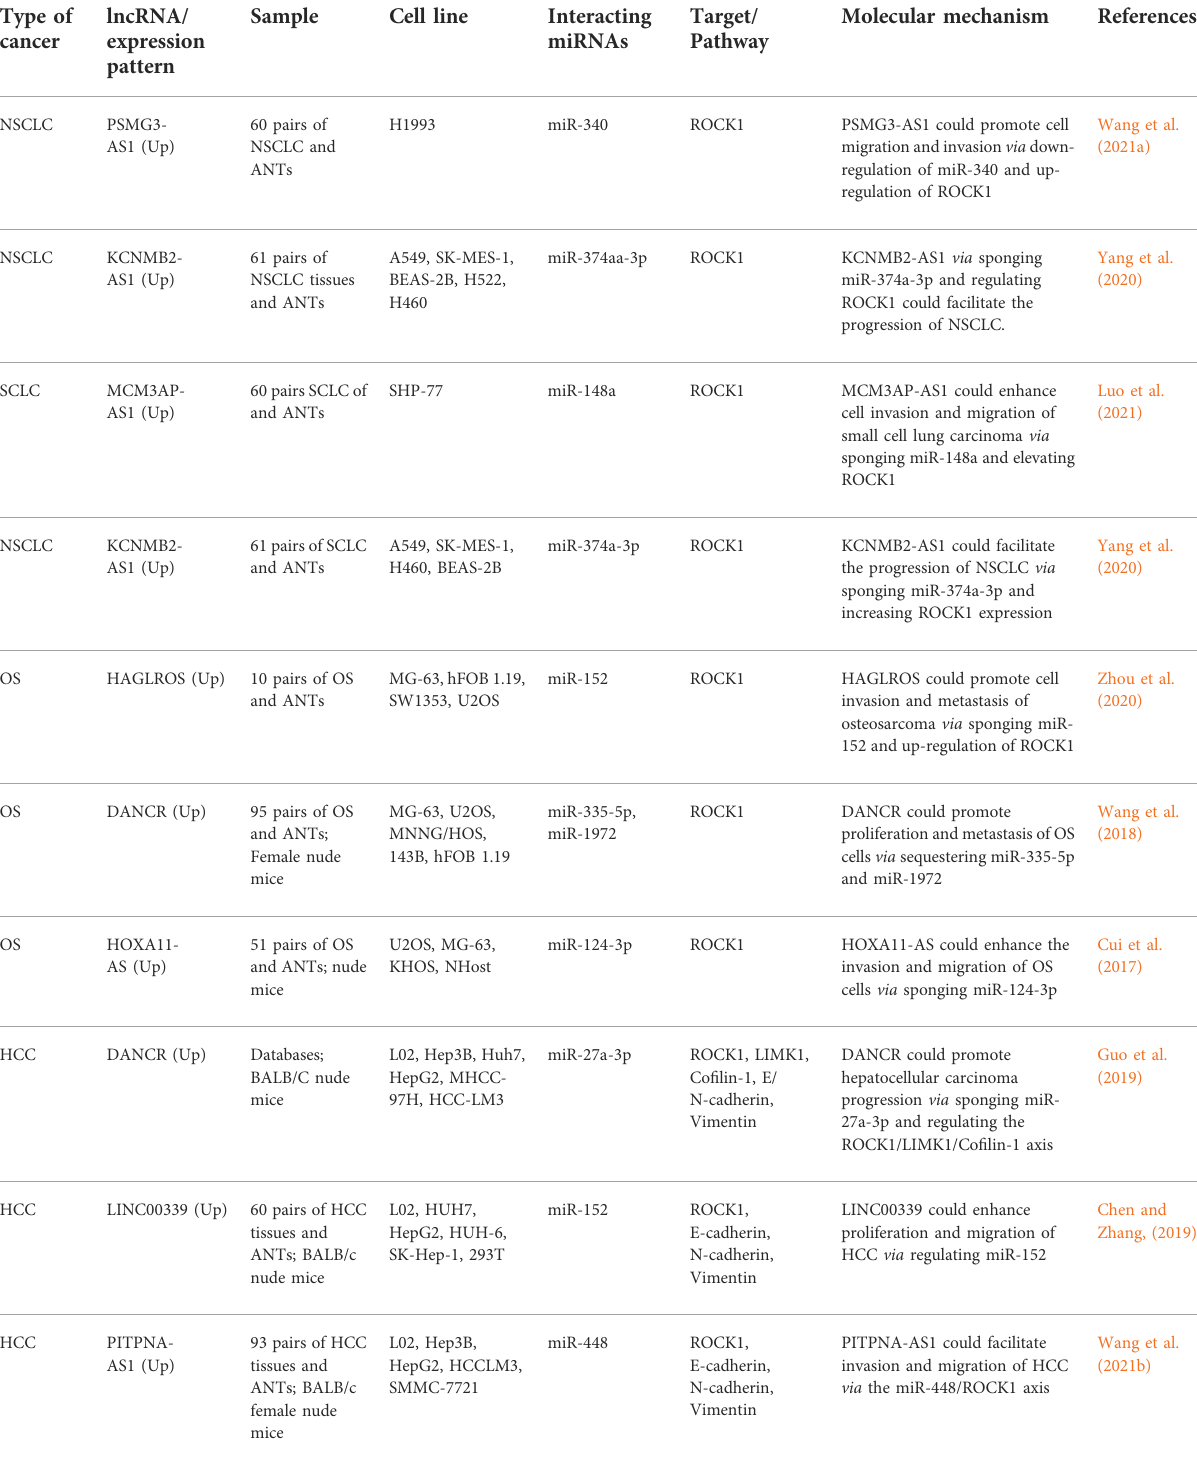
TABLE 6 ROCK1-interacting lncRNAs in cancers (ANT: adjacent non-cancerous tissue, NSCLC: non-small cell lung cancer, OS: osteosarcoma, HCC: hepatocellular carcinoma, ESCC: Esophageal squamous cell carcinoma, CC: cervical cancer, OC: ovarian cancer, BCa: breast cancer, LSCC: Laryngeal squamous cell